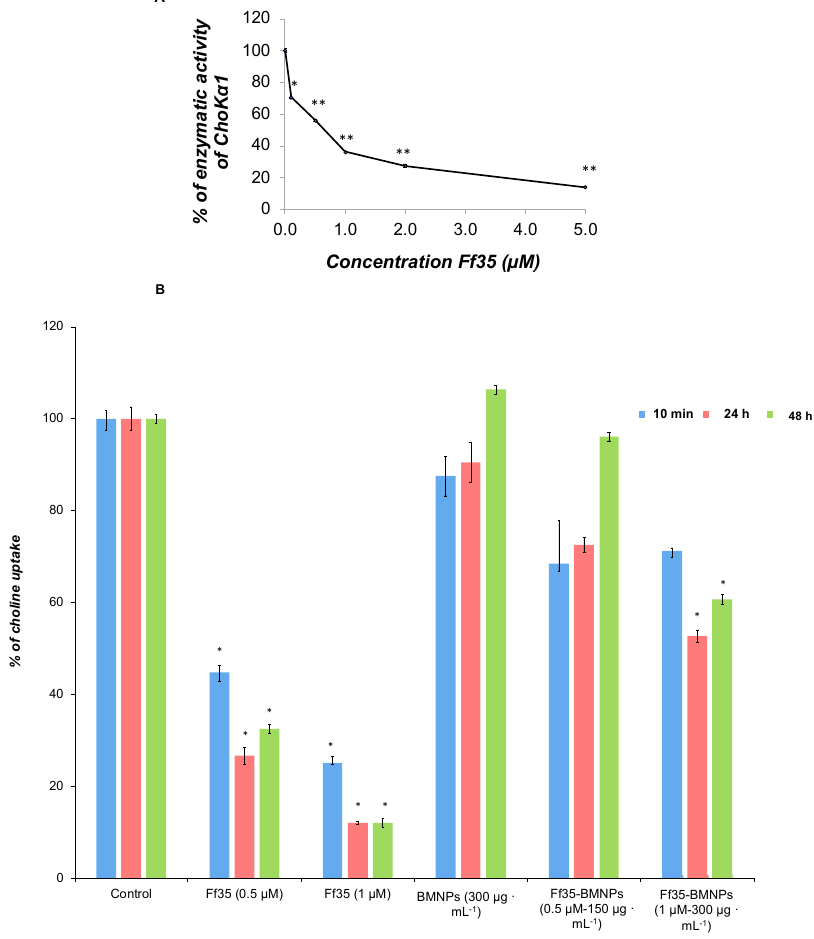
Figure 5. ( A ) Effects of Ff35 on ChoK α 1 activity assayed in purified ChoK α 1 exposed to different Ff35 concentrations. The results are expressed as percentage of enzymatic inhibition. ( B ) Choline uptake assay in HepG2 cells. Choline uptake was determined in cells treated for 10 min, 24 h, and 48 h soluble Ff35 or Ff35-BMNPs. Results are normalized to their respective control. These experiments were performed three times in triplicates. * p < 0.05, ** p < 0.001 compared to their respective controls.